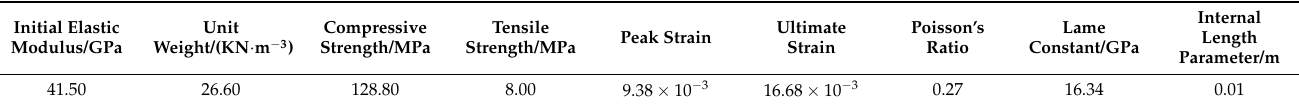
Table 2. Rock parameters in theoretical